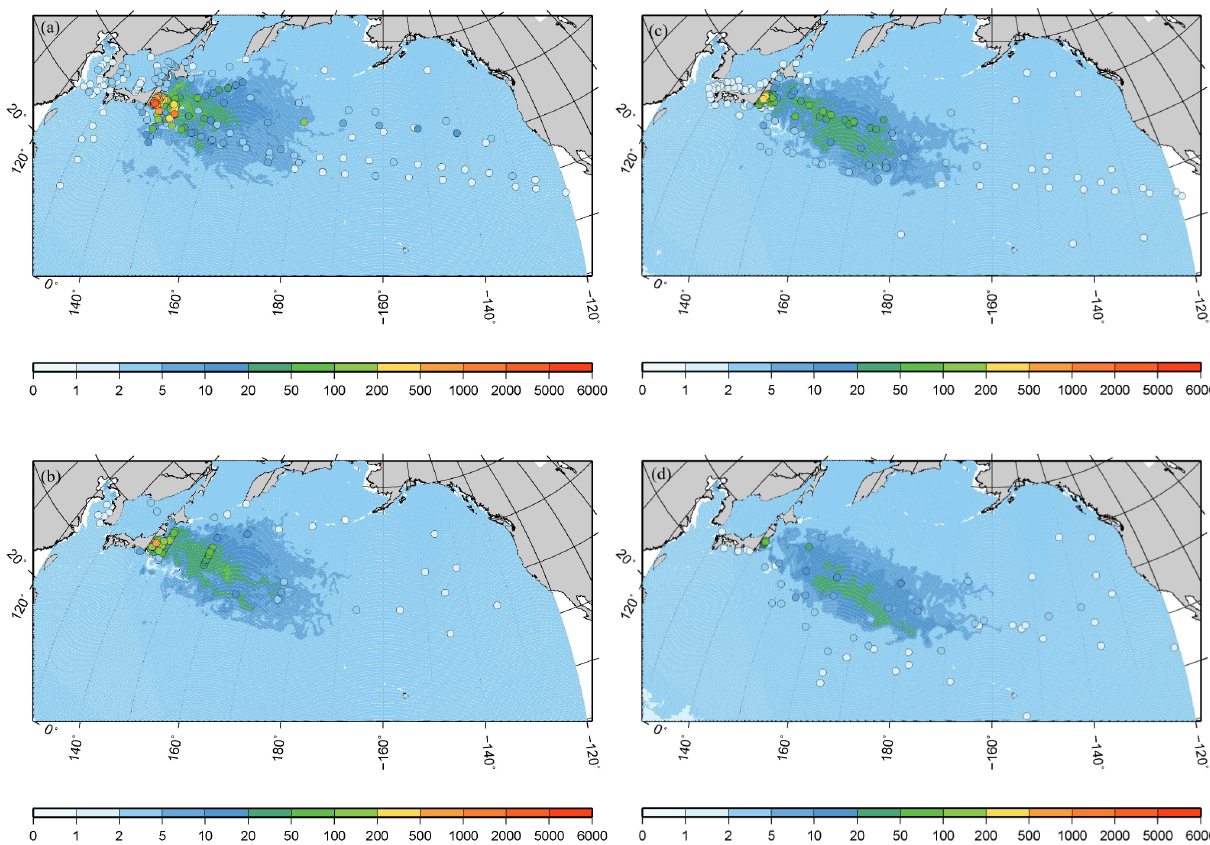
Fig. 4. Simulated 137 Cs activities (Bqm − 3 ) in surface waters (a) on 15 May 2011 and measurements from April to June 2011; (b) on 15 August 2011 and measurements from July to September 2011 (Aoyama et al., 2012c, 2013b). Simulated 137 Cs activities (Bqm − 3 ) in surface waters (c) on 15 November 2011 and measurements from October to December 2011; (d) on 15 February 2012 and measurements from January to March 2012 (Aoyama et al., 2012c,